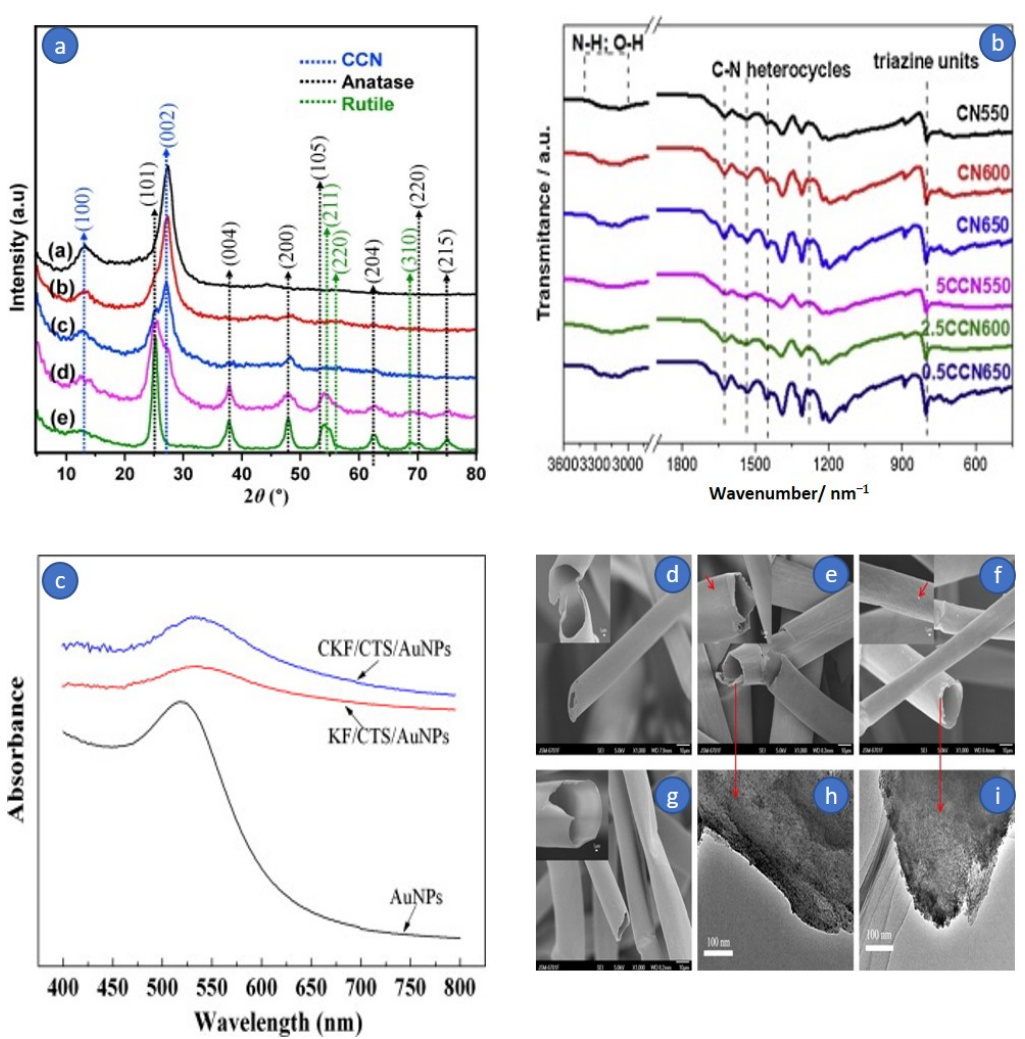
Figure 13. ( a ) C-doped g-C 3 N 4 /TiO 2 heterojunction photocatalyst XRD dispersion pattern regenerated by bio-template technique with varied TiO 2 precursor concentration. ( a ) Pristine CCN. ( b ) CCN/T-0.5. ( c ) CCN/T-1.0. ( d ) CCN/T-1.5. ( e ) CCN/T-2.0. Reprinted with permission from Ref. [123]. Copyright 2019, copyright Elsevier. ( b ) FTIR wavelengths of CN550, CN600, and CN650 samples, as well as KF-treated samples (5CCN550, 2.5CCN600, and 0.5CCN650). Reprinted with permission